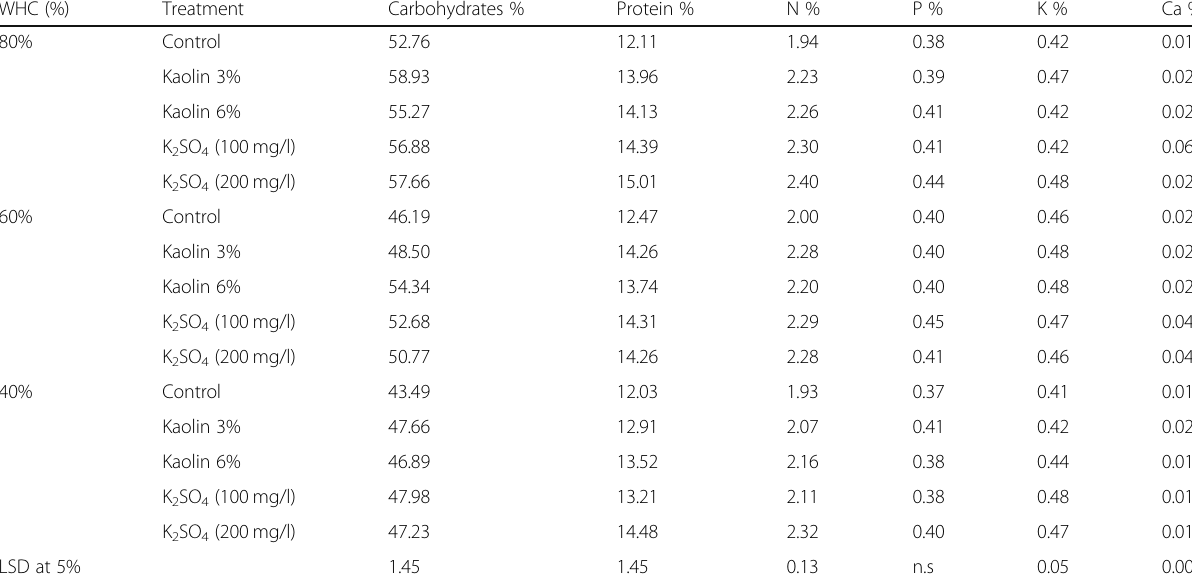
Table 8 Effect of different concentrations of kaolin or K 2 SO 4 under different levels of water holding capacity on carbohydrate percentage, protein percentage, and elements (N, P, K, and Ca %) of wheat grains (combined analysis of two seasons) WHC